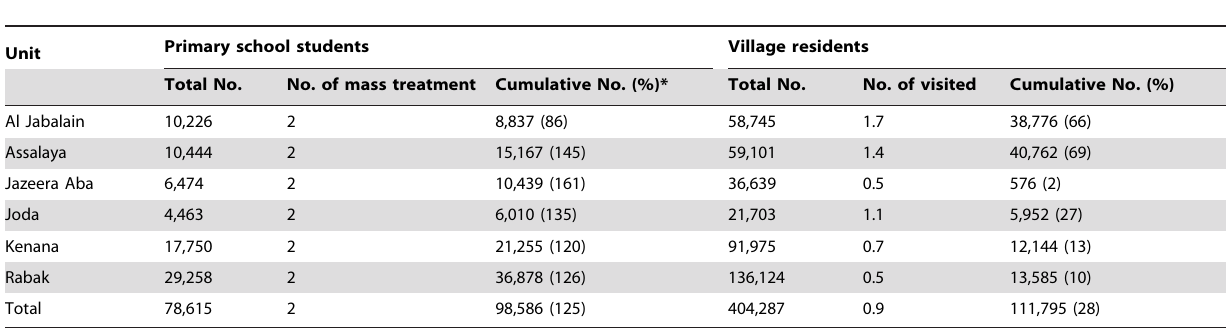
Table 8. Cumulative number of participants treated with praziquantel at Al Jabalain locality of White Nile State, Sudan.